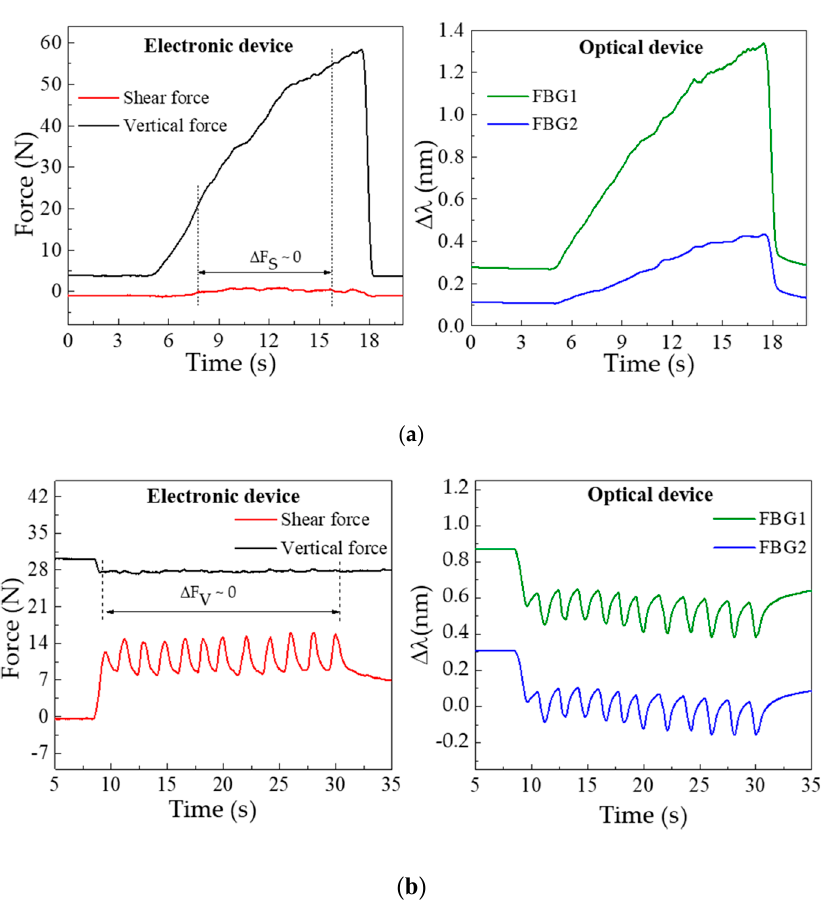
Figure 3. Data acquired by the three-axial electronic (left) and optical fiber (right) based systems, for the ( a ) vertical and ( b ) shear forces characterization.